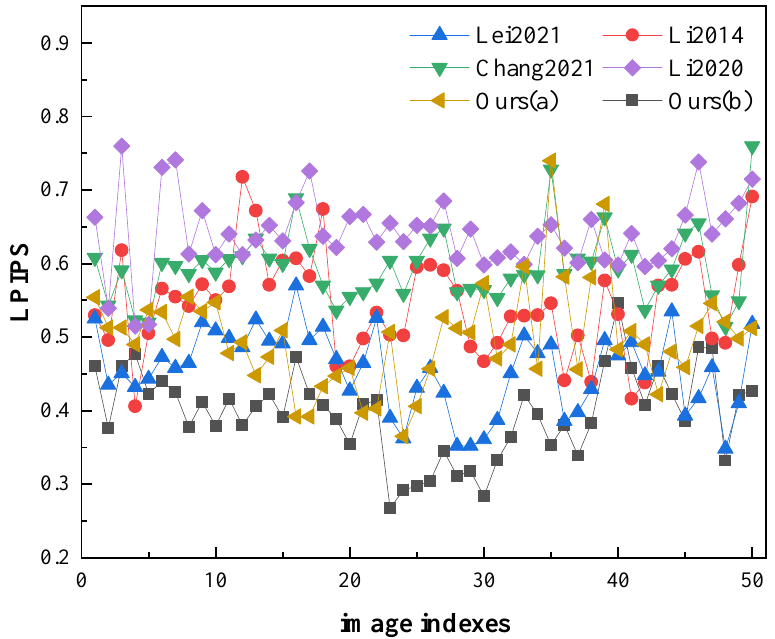
Figure 9. LPIPS value comparisons of the transmission removal results on all 50 real-world mixture images. Lei2021: [13], Li2014: [14], Chang2021: [16], Li2020: